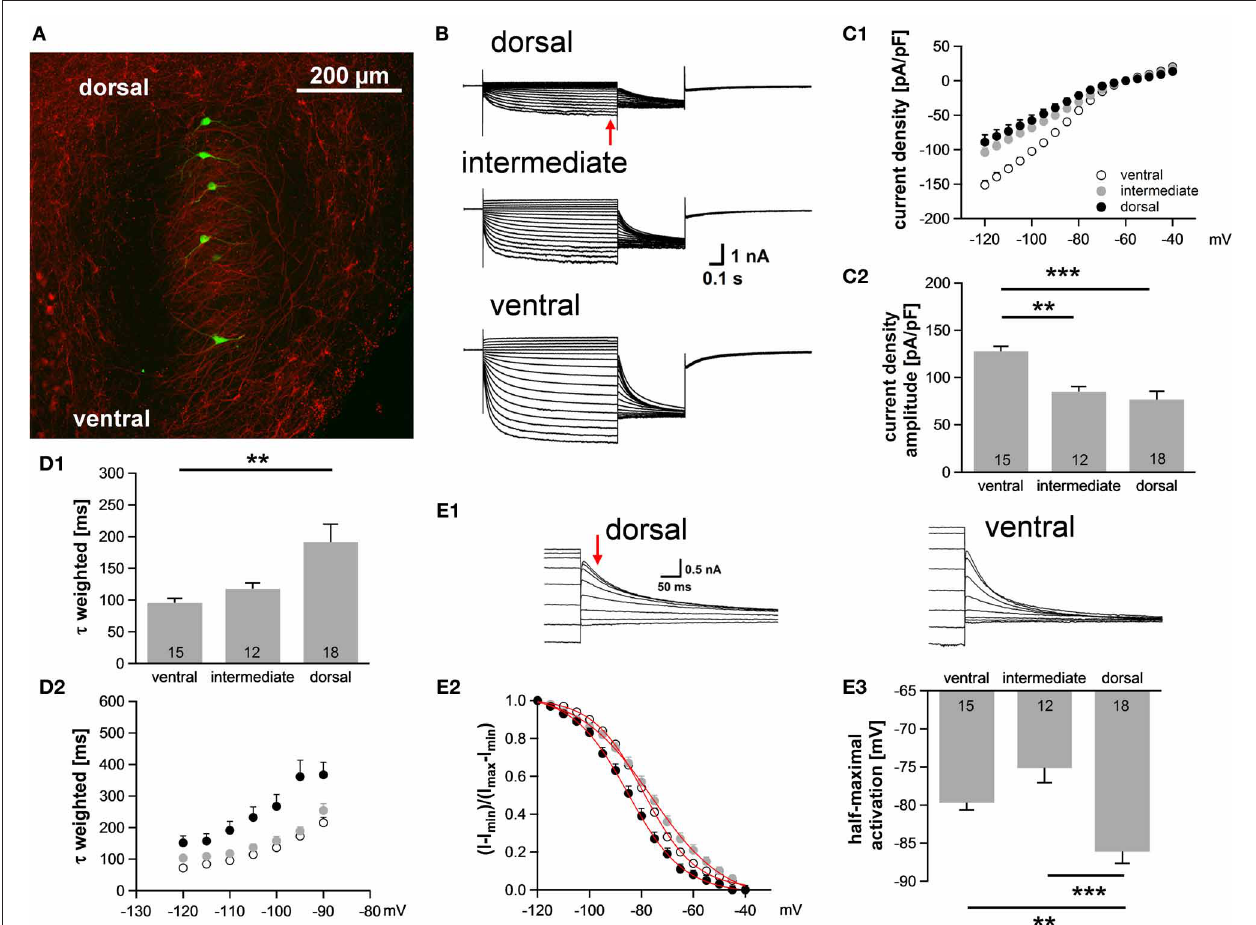
FIGURE 1 | I h varies systematically along the dorsoventral axis. (A) A brain slice containing the MSO with Alexa-488-filled neurons (green) verifies the distribution of the patched neurons along the dorsoventral axis (red: MAP-2). (B) Pharmacologically isolated I h current traces were elicited by depolarizing and hyperpolarizing voltage steps from − 60.5mV to potentials between − 40.5mV and − 120.5mV for 1s in 5mV step increment and then to − 100.5mV for 0.5s to elicit the tail current to determine the voltage dependence of I h activation. Current traces are representative for the dorsal, the intermediate and the ventral part of the MSO. (C) I-V relationships of steady-state (red arrow in B ) I h density for ventral ( n = 15), intermediate ( n = 12) and dorsal ( n = 18) neurons emphasize that I h density amplitudes are smallest in dorsal neurons and